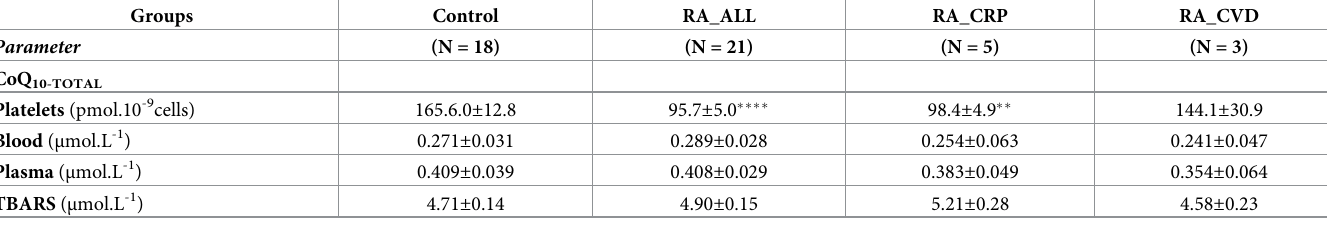
Table 3. Endogenous coenzyme Q 10-TOTAL and TBARS in control subjects and in RA patients.